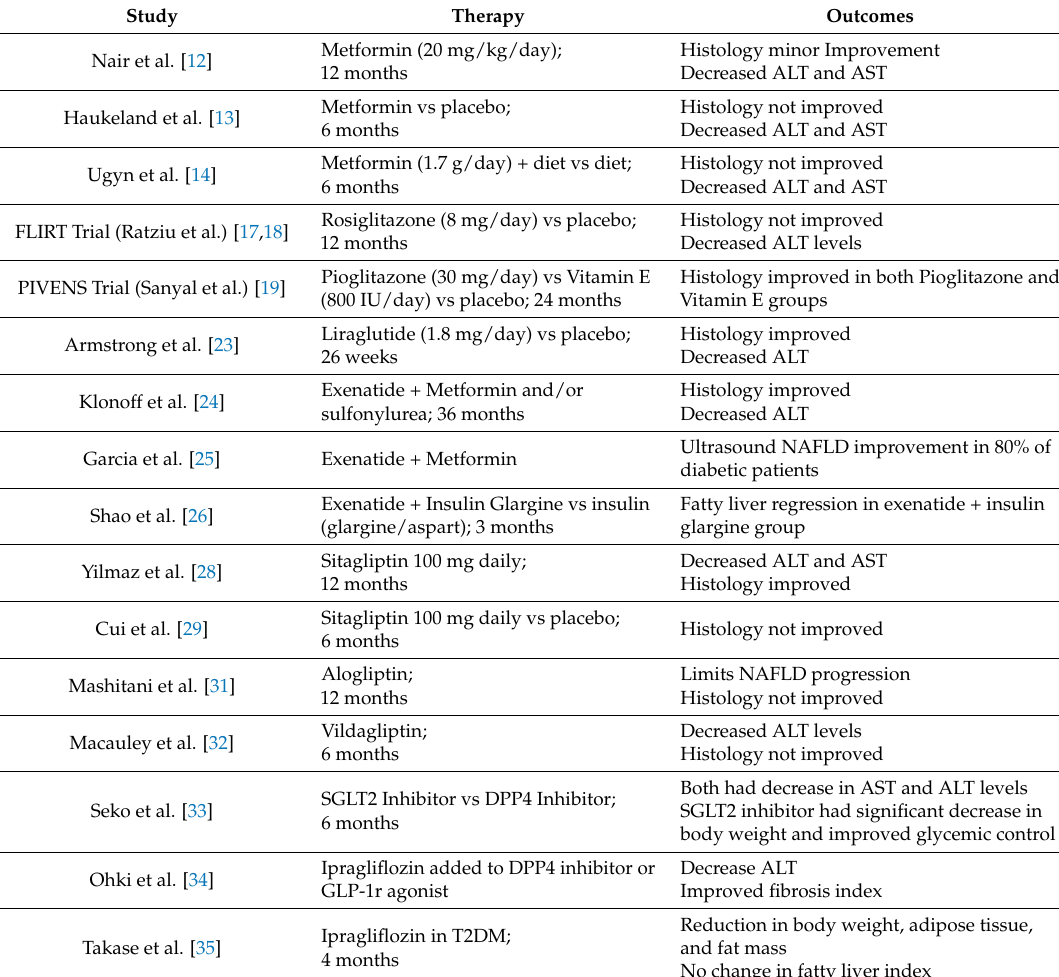
Table 2. Anti-diabetic therapy for NAFLD and associated outcomes on liver histology and